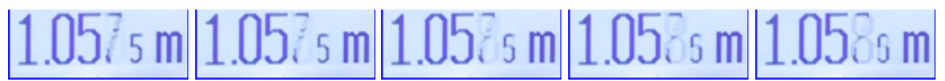
Figure 6. Changes of measured values recorded on BOSCH GLM 80 LDM for five consecutive frames of the RGB